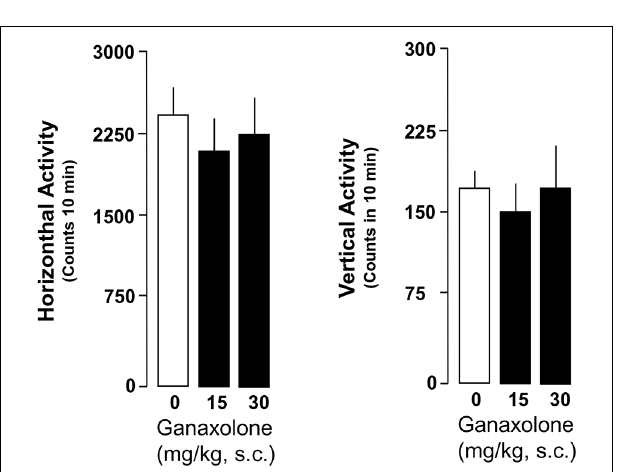
FIGURE 6 | Ganaxolone did not alter exploratory activity determined as means of horizontal and vertical activity in SI mice even at the highest dose (30 mg/kg) tested. The lowest doses of ganaxolone (3.75 and 7.5 mg/kg, s.c.) exhibit a trend to increase both horizontal and vertical locomotor activity in SI mice. Data represent the mean ± SEM of six to eight SI mice.